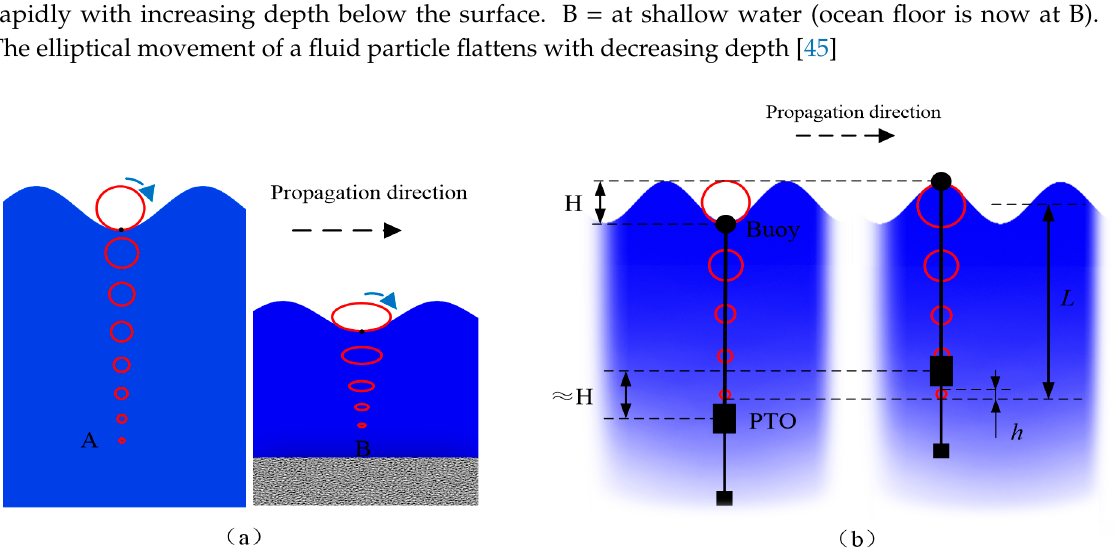
Figure 5. Motion of a particle and WEC in an ocean wave: ( a ) the movement of water particles in deep water and shallow water; ( b ) the SVP drifter in ideal deep-water.